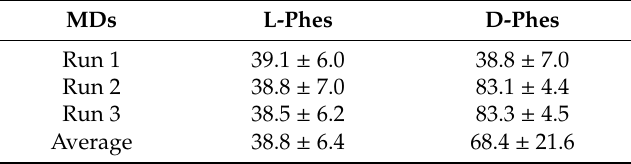
Table A2. Average tilt angle in the last 100 ns simulations Table 2. Average tilt angle in the last 100 ns simulations (MD3).